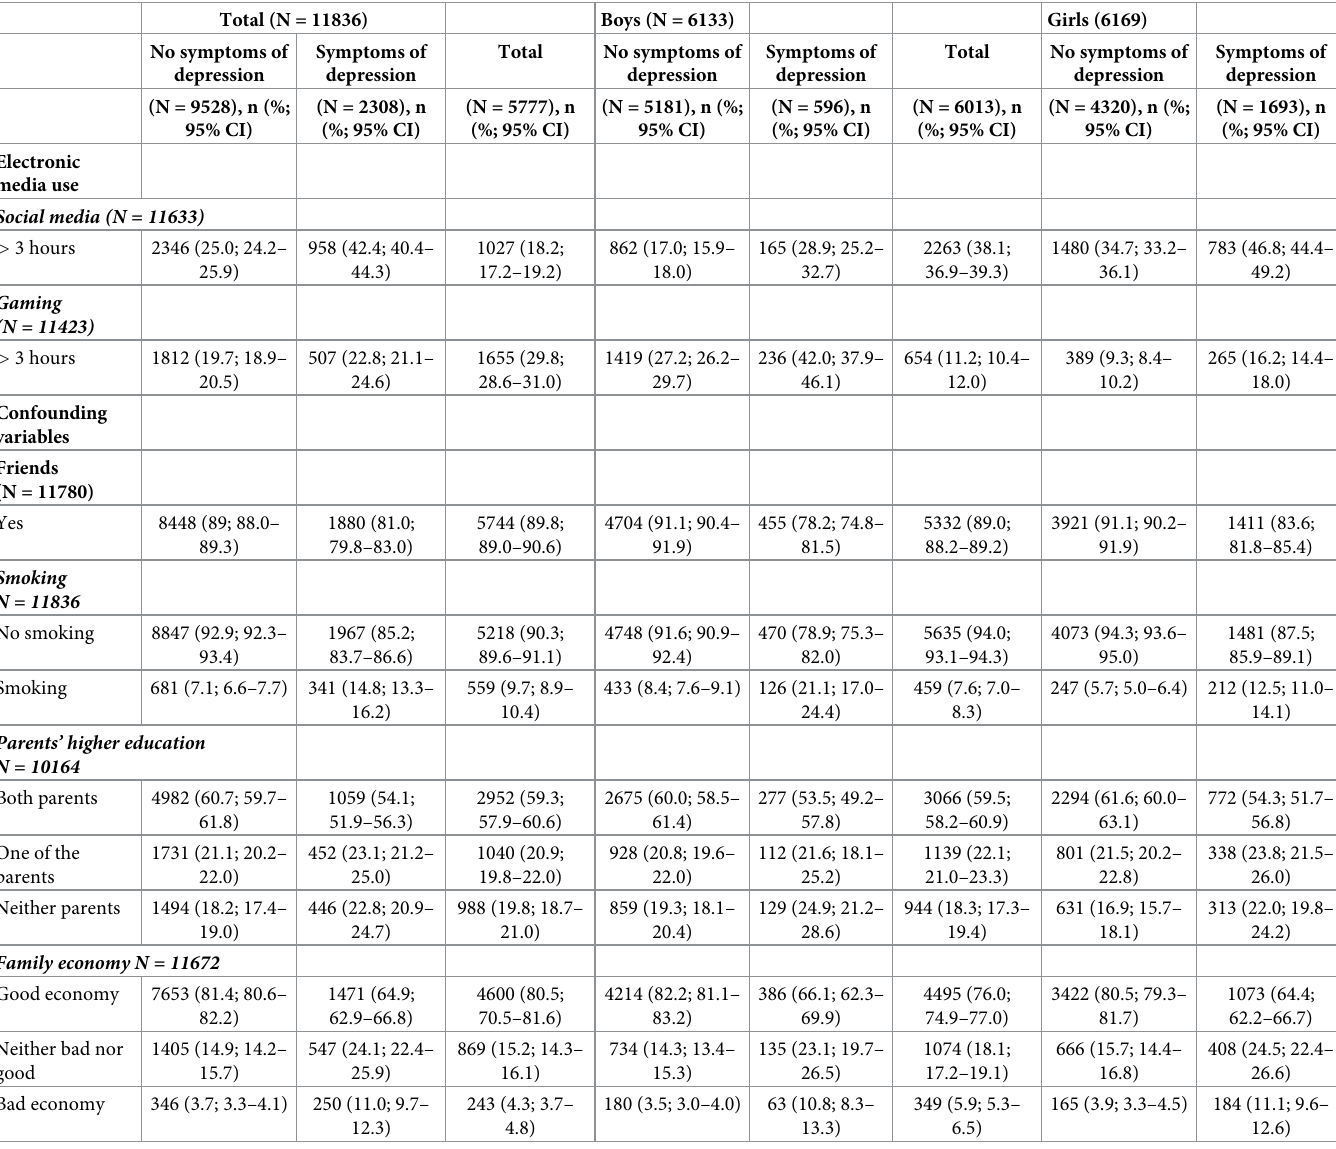
Table 2. Youth data surveys: Baseline characteristics of adolescents, aged 15–16 years in 2018, according to symptoms of depression and